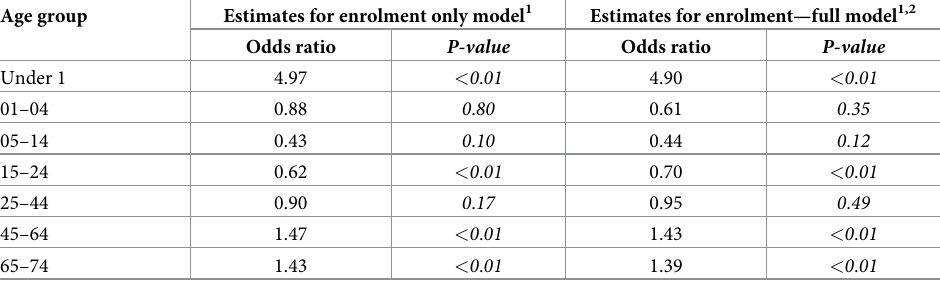
Table 4. The association between enrolment and amenable mortality, stratified by age. Age group Estimates for enrolment only model 1 Estimates for enrolment—full model